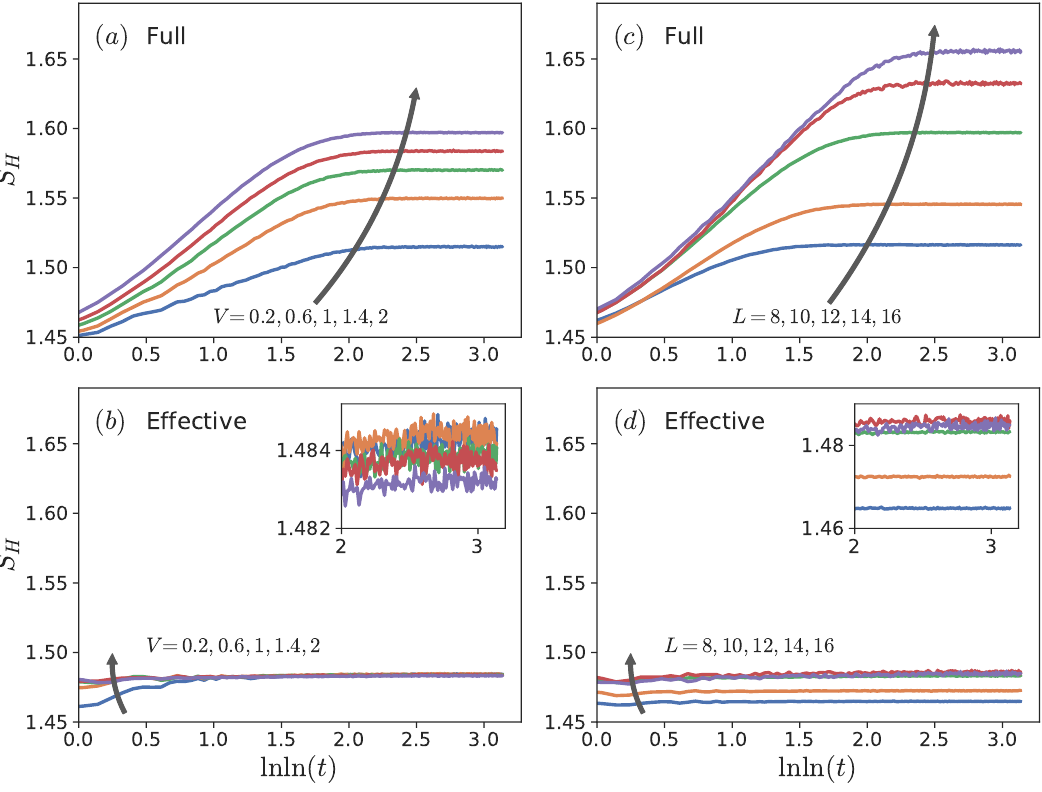
Figure 4: Hartley number entropies for L = 8,10 (200000 samples), L = 12 (40000 samples), L = 14 (4000 samples), and L = 16 (3000 samples) with D = 20: The full model is shown in the top row, the effective model in the bottom row. Left column (a,b): dependence on interaction V for L = 12, right column (c,d): dependence on length L for V = 2.0. For the effective model the insets show a zoom-in into the time frame where S H